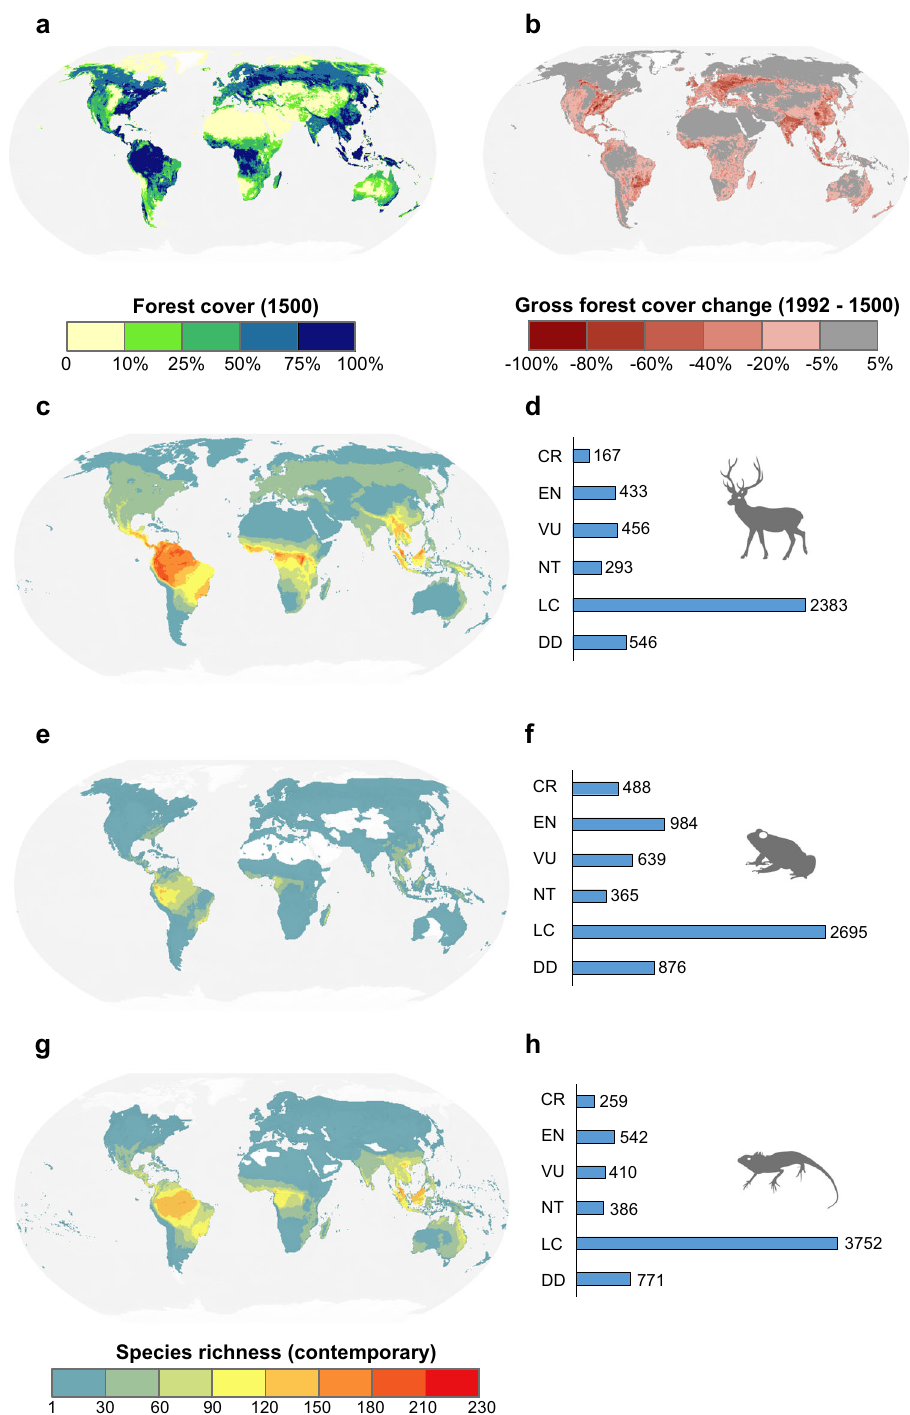
Fig. 1 Overview of global forest cover change and forest-dwelling vertebrate species richness. Forest cover for the year 1500 reconstructed using ensemble weighting of backward, forward and JP algorithms a . Percent gross forest cover change (unit: %) from 1500 to 1992 b . Contemporary species richness of all forest-dwelling mammals c , amphibians e , and reptiles g ; The IUCN Red List categories for mammals d , amphibians f , and reptiles h are accompanied on the corresponding right side. CR critically endangered, EN endangered, VU vulnerable, NT near threatened, LC least concern, DD data de fi cient. The projection system is the Robinson projection, and the base map was obtained from Natural Earth